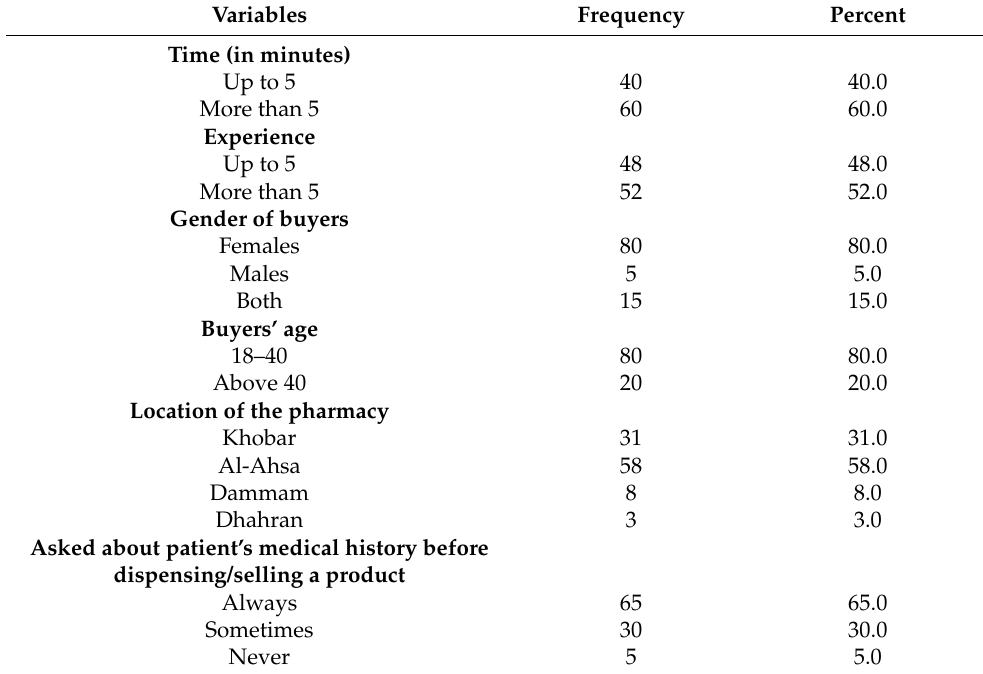
Table 1. Background